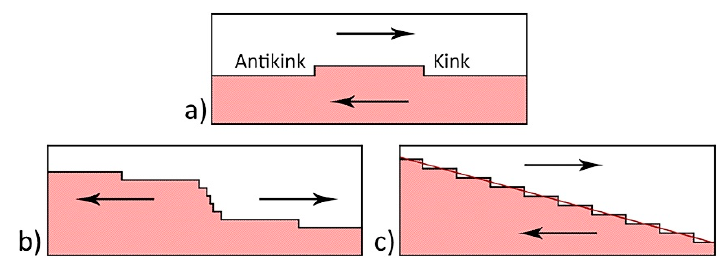
4 of 12 Figure 2. PFM images of the domain walls. Three types of the domain wall fragments: Charged ( a ) head-to-head, ( b ) tail-to-tail, and ( c ) neutral. Lateral PFM contrast. Red and blue arrows indicate the direction of spontaneous polarization within domains. Arrows b and c show the directions of crystal axis. Most tail-to-tail type charged domain walls were perpendicular to the polar axis, while head-to- head type walls were more often inclined. This suggests that the charged tail-to-tail domain walls are conductive and facilitate and accelerate the bulk screening of the depolarizing fields created by the bound charges [28–30]. On nonconductive head-to-head-type charged domain walls, the depolarizing fields were not fully compensated, which led to a change of the domain wall shape to reduce the density of bound charges. The formation of the strip-like as-grown domain structure with flat charged domain walls and their smooth change in orientation near the edges of the crystal can be attributed to the growth mode of glycine crystals. We suppose that the fast growth facet was oriented perpendicular to the polar axis and consisted of the growth sectors separated by boundaries [31]. These boundaries are internal surfaces over which the edges between neighbored faces have been swept during growth. These interfaces are readily seen in the topography images (not shown) and may contain an increased concentration of defects or deviations from the stoichiometric composition [32,33]. Nonuniform concentration of defects at different stages of crystal growth can occur because of fluctuations in the growth rates of the faces, which are caused by cyclic changes of the temperature and oversaturation [34,35]. The local direction of polarization is determined by the defect concentration gradient;